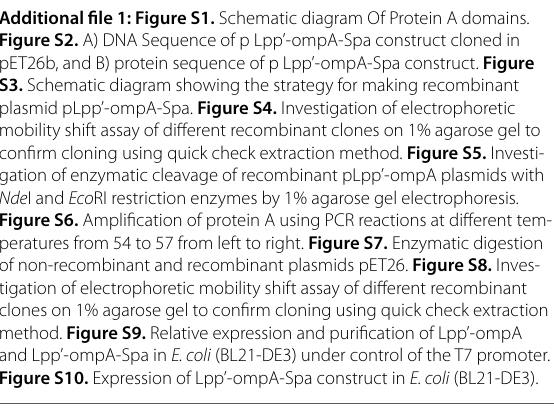
Figure S10. Expression of Lpp’-ompA-Spa construct in E. coli (BL21-DE3). Abbreviations SpA: Staphylococcus aureus protein A; IgG: Immunoglobulin G; ompA: Outer membrane protein A; Lpp’-ompA: Truncated outer membrane protein A; IPTG: Isopropylthiogalactopyranoside; IgBDs: Ig-binding domains; LB medium: Luria–Bertani